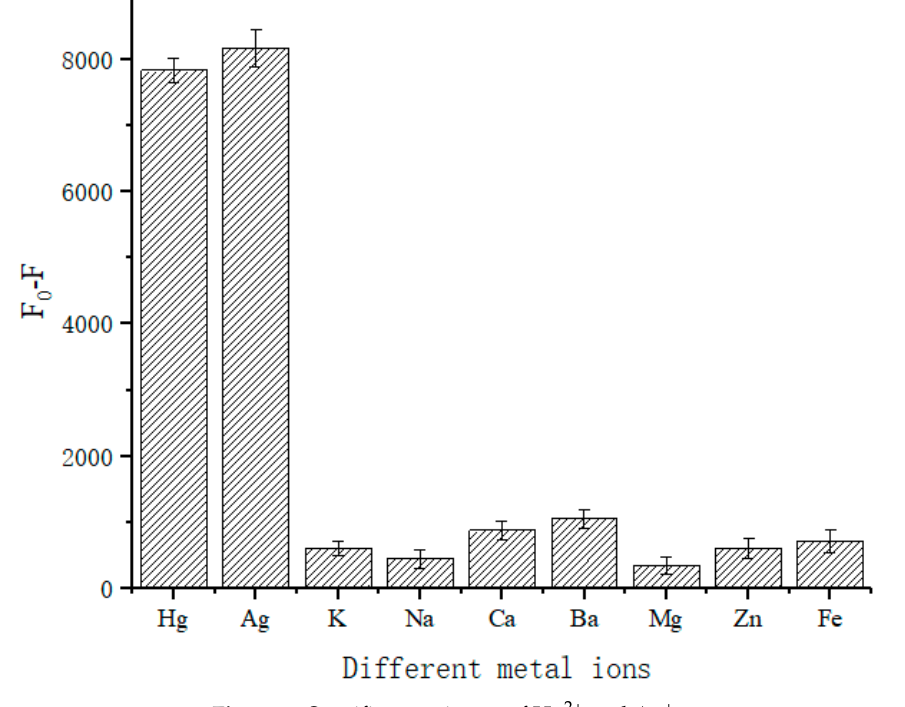
Figure 9. Specific experiment of Hg 2+ and Ag +.